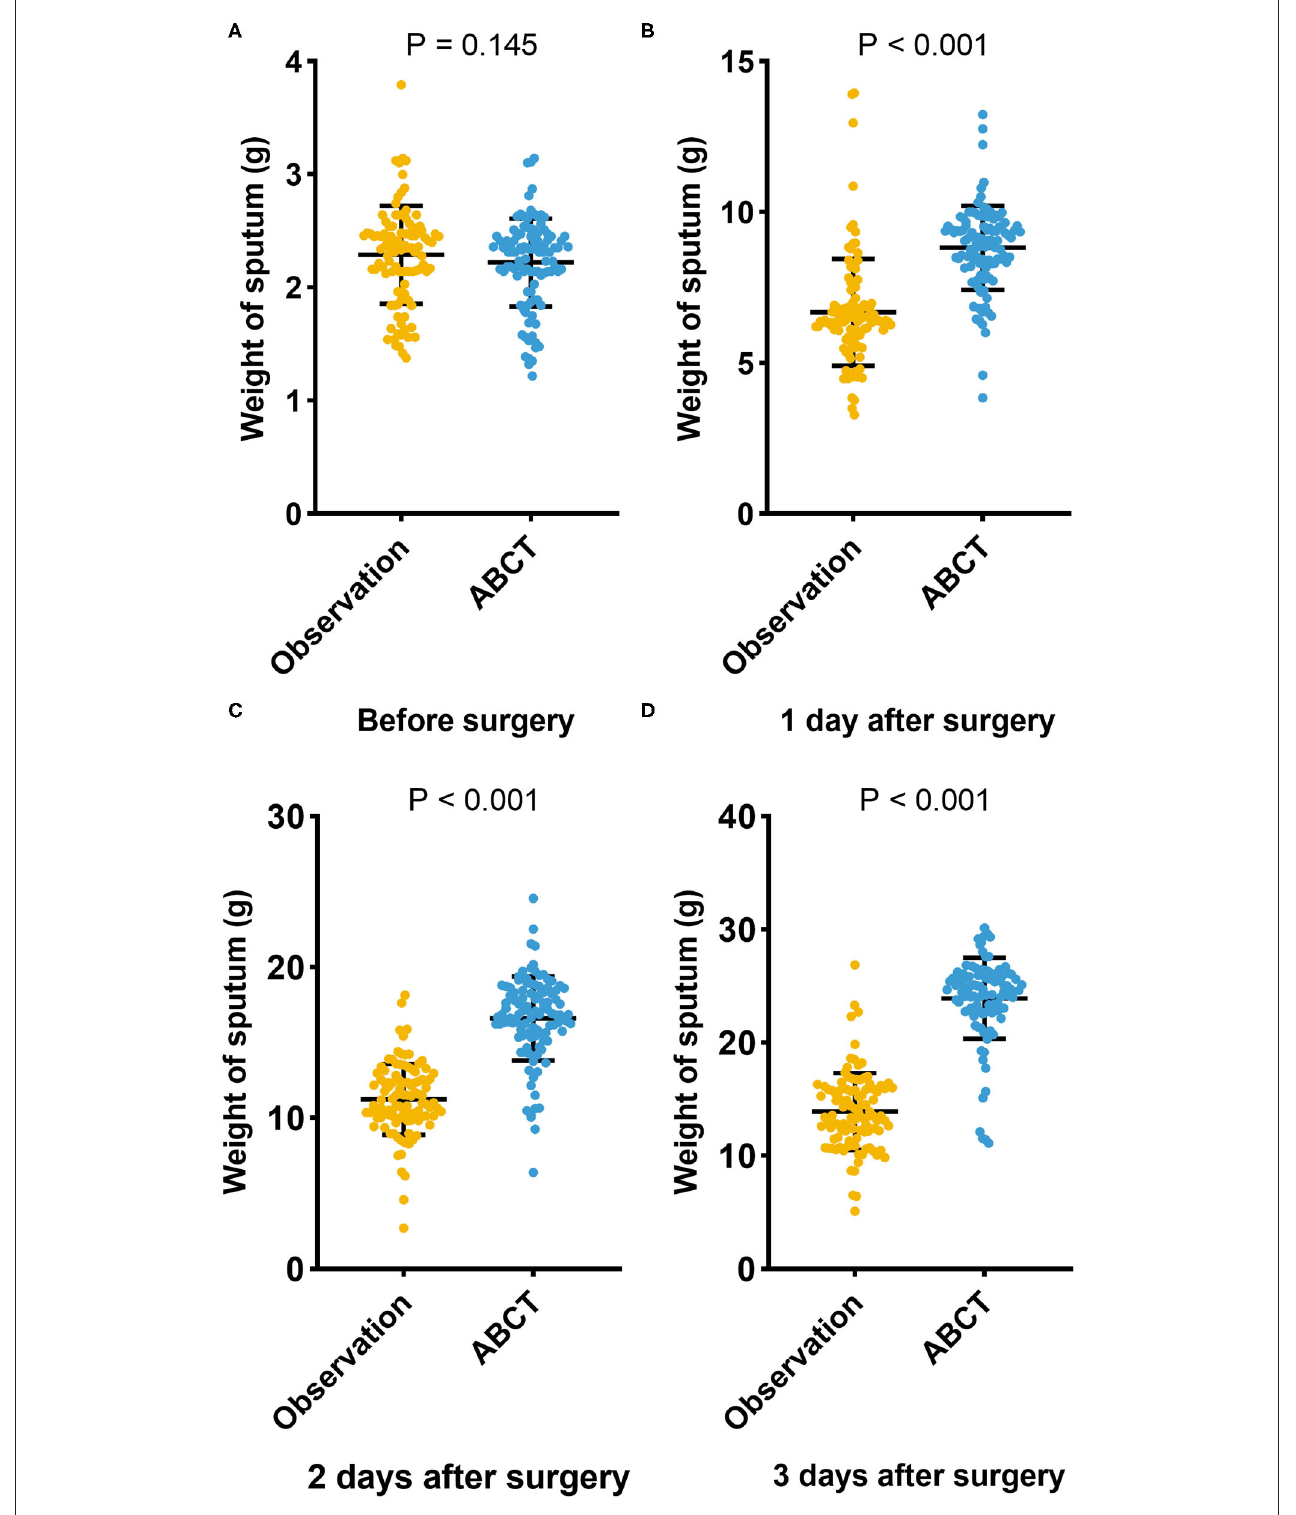
FIGURE 3 | The weight of sputum in two groups before surgery (A) , in 1 day after surgery (B) , in 2 days after surgery (C), in 3 days after surgery (D) .